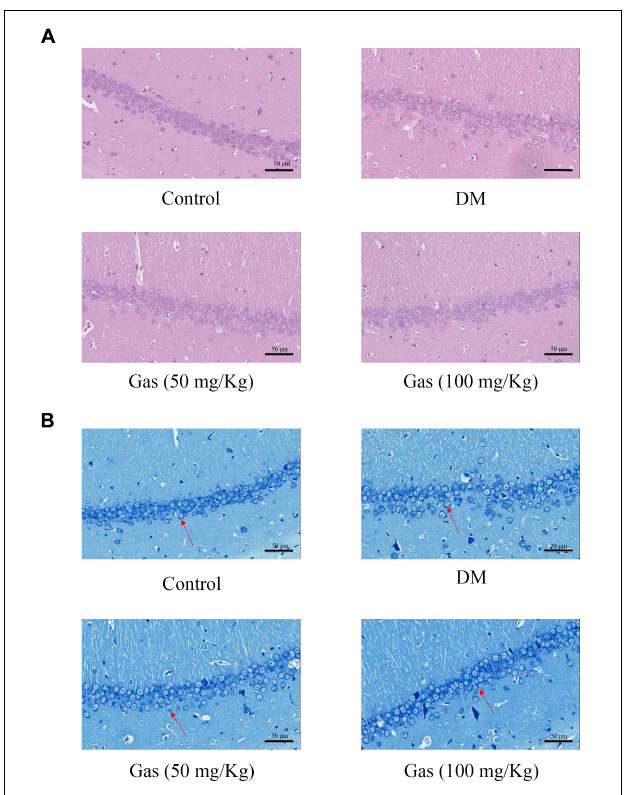
FIGURE 6 | Gas prevented neuronal apoptosis in the hippocampus of DM rats. (A) HE staining in the hippocampal CA1 region for each group. (B) Nissl staining in the hippocampal CA1 region for each